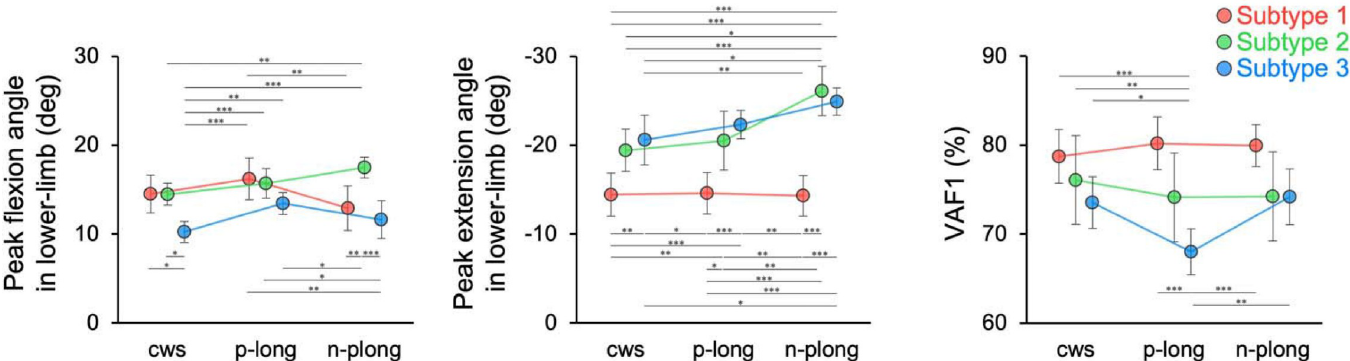
Fig 2. Comparison of walking parameters and VAF1 in each walking condition. The data are reported as the mean ± 95% confidence interval. The peak flexion angle of the lower-limb, the peak extension angle of the lower-limb, and the VAF1 are shown from left to right. The colors indicate subtype differences and represent these variables across walking conditions (i.e., cws, p-long, and np-long conditions). The peak flexion and extension angles of the lower-limb differed among gait conditions for subtypes 2 and 3. VAF1 of subtype 3 had a reduced p-long compared to the cws condition. On the other hand, VAF1 in subtypes 1 and 2 did not differ in each walking condition. � p < 0.05, �� p < 0.01, ��� p < 0.001. Abbreviations: cws, comfortable walking speed; p-long, paralytic side long step; np-long, non-paralytic side long step; VAF,